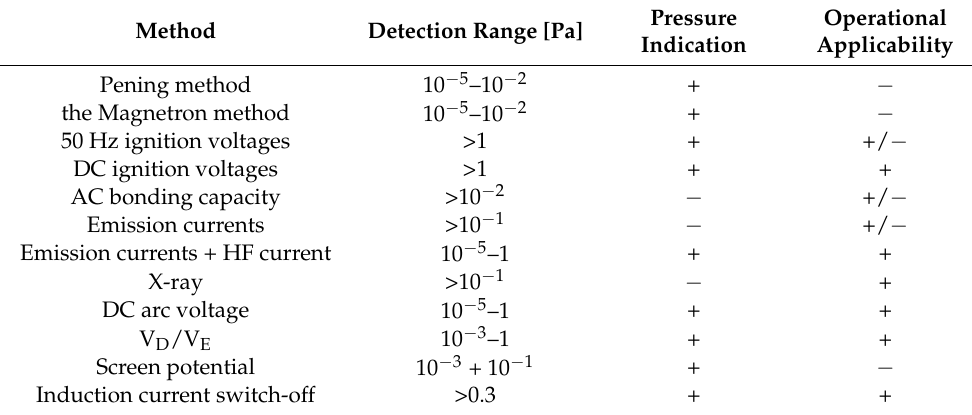
Table 3. Diagnostic methods for vacuum equipment